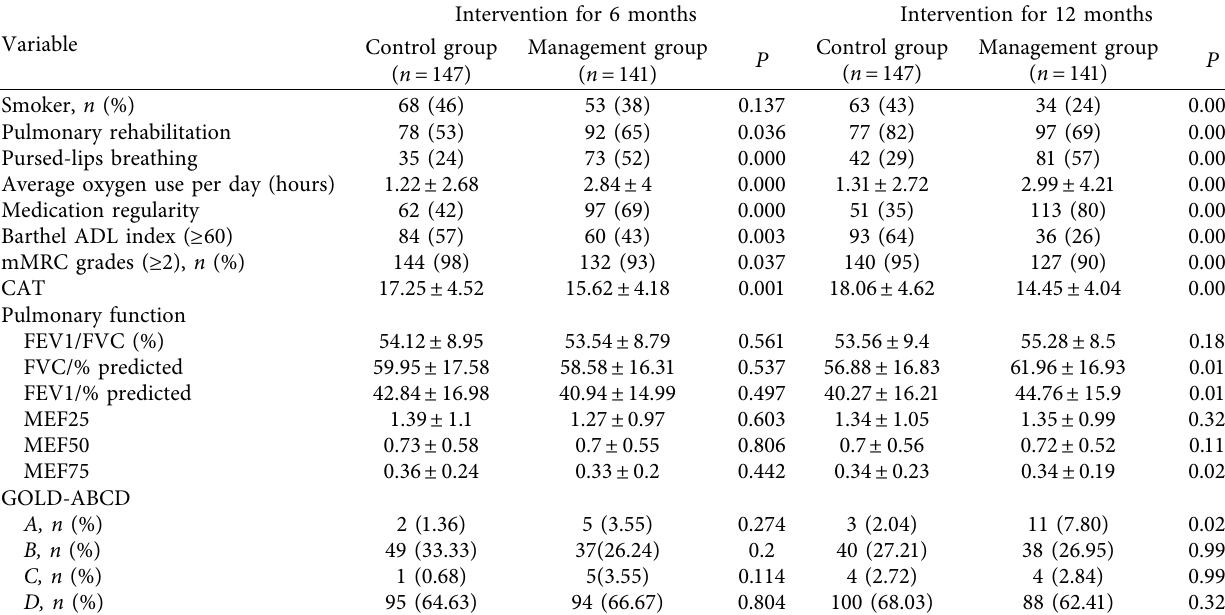
Table 2: Differences in clinical characteristics between subjects of the control group and the management group after intervention.